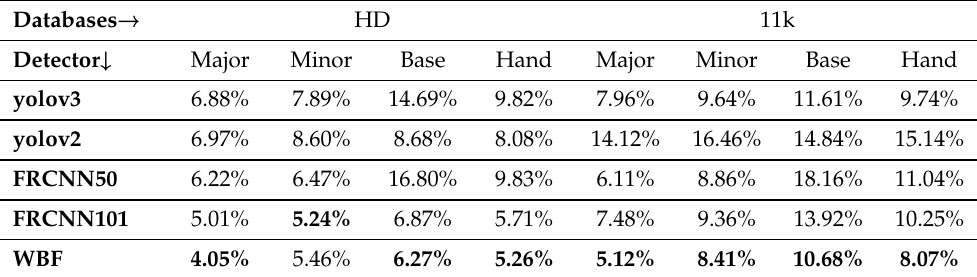
Table 8. Comparison of mean-EER for the public databases.